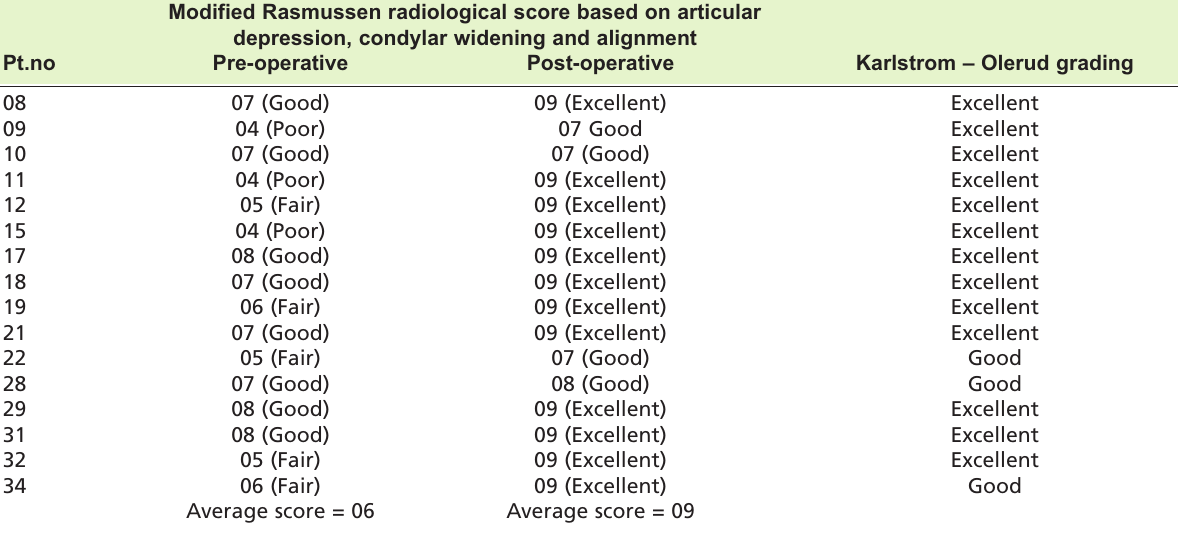
Radiological and functional scores of patients with type V fractures Table IV: Modified Rasmussen radiological score based on articular